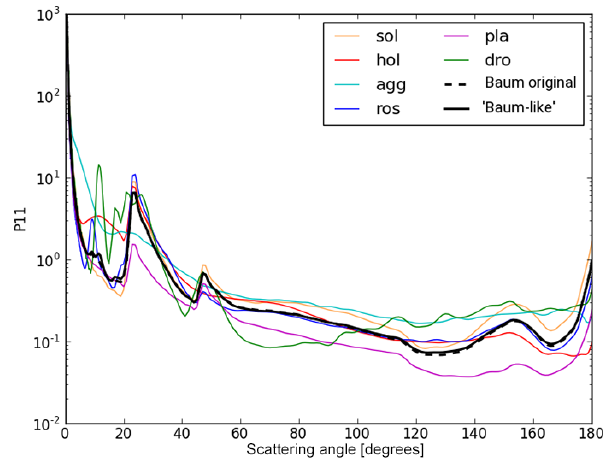
Figure 1. Phase functions of individual habits (coloured lines), orig- inal Baum et al. (2005) and “Baum-like” reproduced habit mix- tures (black lines) for r eff = 50µm and λ = 550nm. Crystal habits shown are droxtals (dro), plates (pla), bullet rosettes (ros), aggre- gates (agg), solid (sol) and hollow (hol) hexagonal columns.